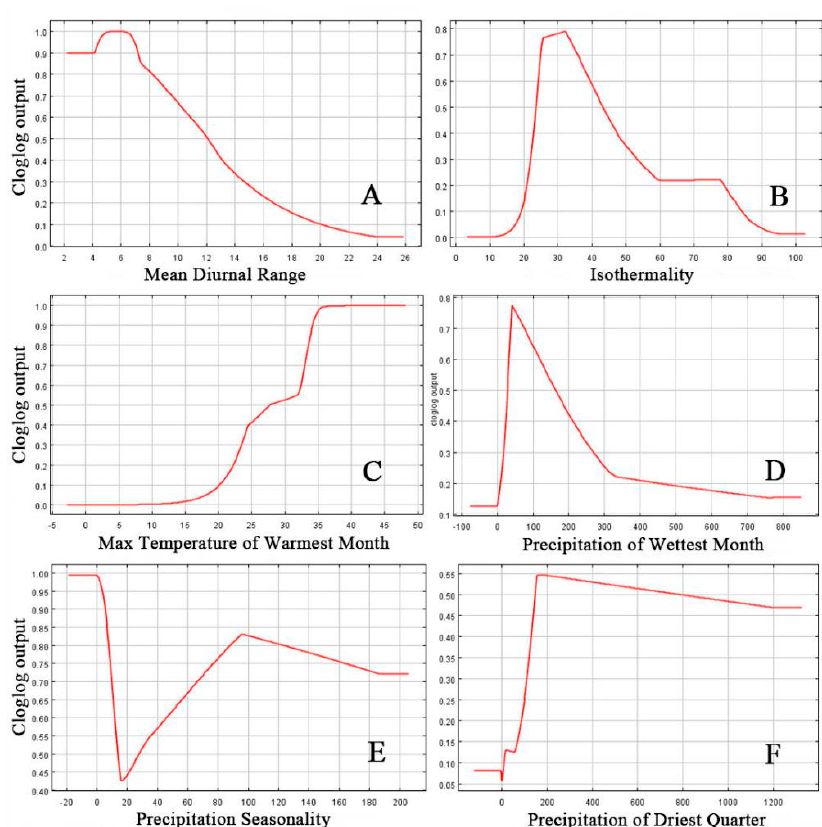
Figure 5. Variable response curve of Mean Diurnal Range ( A ), Isothermality ( B ), Maximum Temperature of the Warmest Month ( C ), Precipitation of the Wettest Month ( D ), Precipitation Seasonality ( E ) and Precipitation of Driest Quarter ( F ).